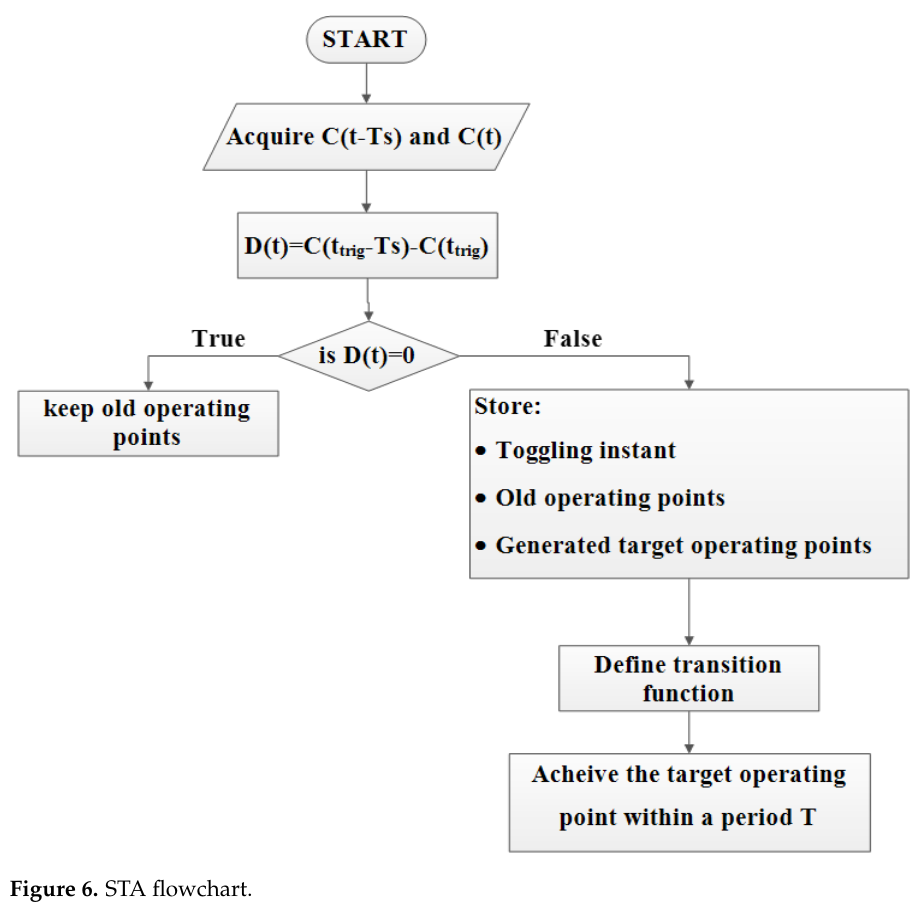
Figure 5. Linear-based transition function.